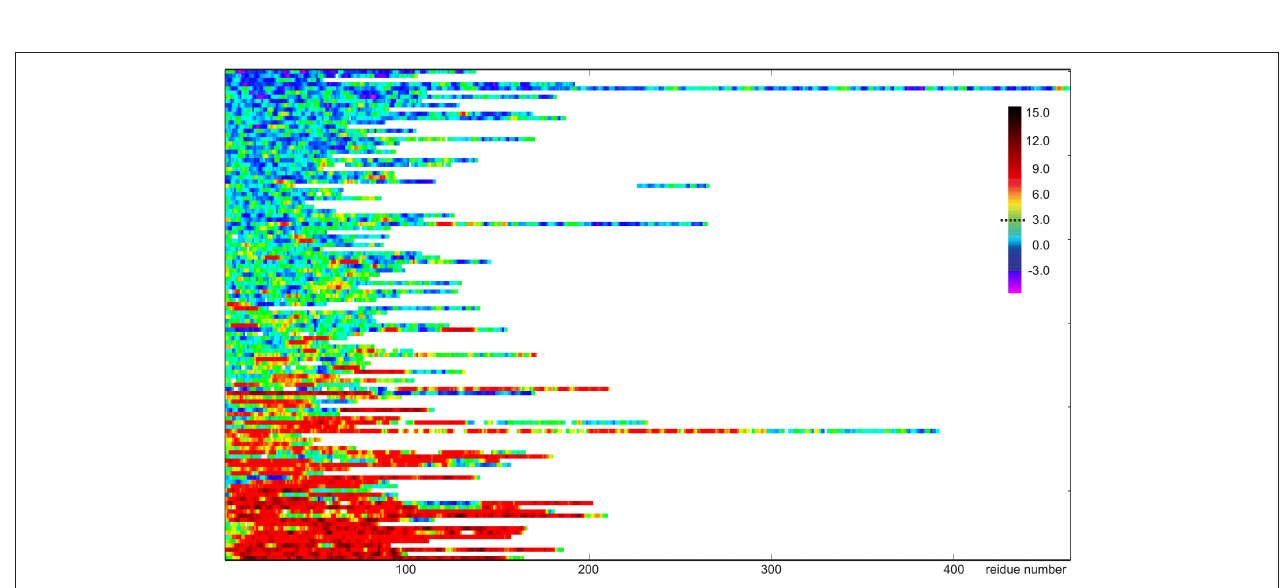
FIGURE 1 | Examples of IDP disorder profiles. (A–G) weighted difference between observed and predicted shifts, 1 jn (Equation 2) shown with blue, red, black, green, cyan, magenta, and yellow dots for C ′ , C α , C β , H α , H N , N, and H β , respectively. The Z-score (Equation 4) is shown as a black line, showing the lines, Z = 0 and Z = 3 for reference with black broken lines. The name of the protein analyzed is indicated at the top of each panel to the left. Three numbers are provided on top of each panel (middle) referring to, the BMRB id, the fraction of disordered residues, and the sequence disorder complexity, respectively.